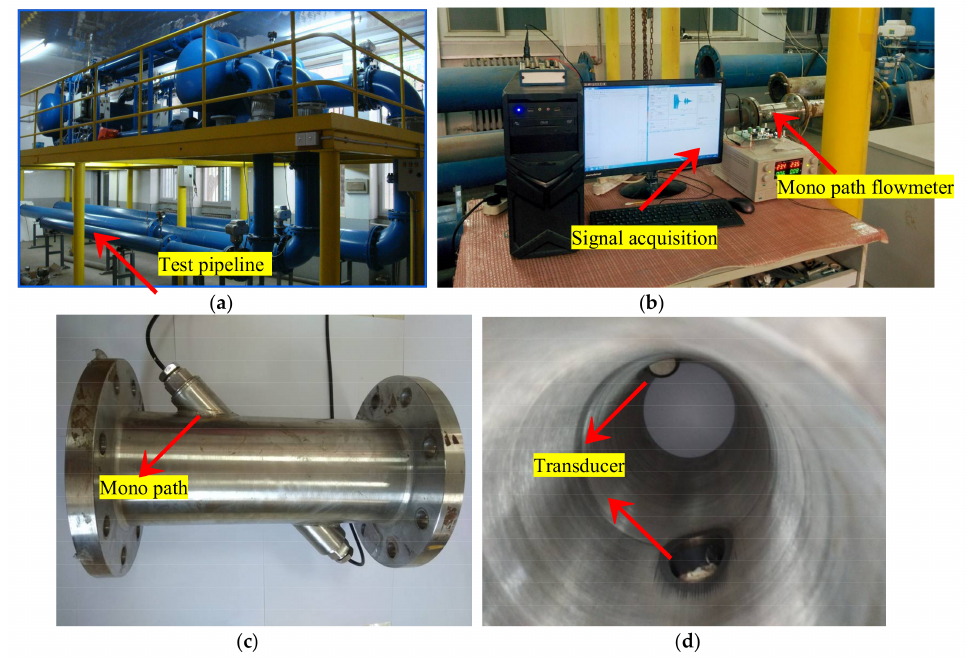
Figure 18. Experimental device and signal acquisition. ( a ) Gas flow device. ( b ) Signal acquisition. ( c ) Flowmeter with a single path. ( d ) Position of the